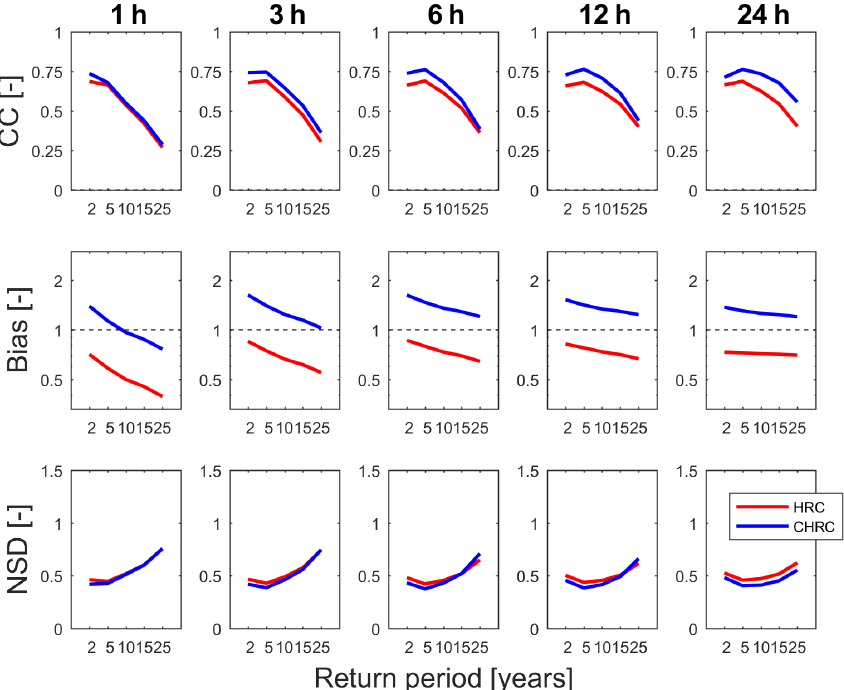
Figure 6. Comparison of IDF values between HRC and radar (red) and CHRC and radar (blue). The upper row of panels shows the CC for different durations, the middle row the bias and the lower row the